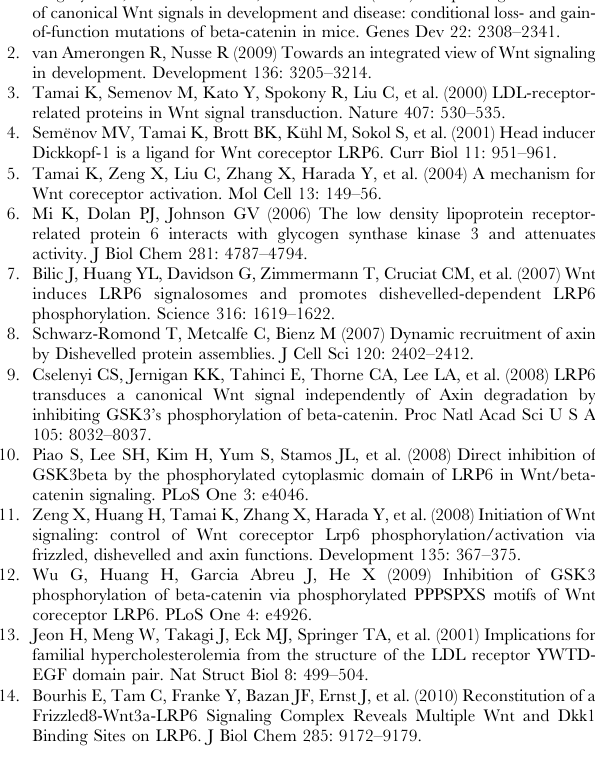
Figure S4 Apomab antibody crosslinking induces apoptosis in HT-1080 cells. We utilized the crosslinking-dependent proapop- tosis activity of Apomab antibody to optimize experimental conditions for crosslinking receptors on HT-1080 cells by either the whole IgG or F(ab 9 )2 fragment of anti-human-Fc antibodies (NA indicates no crosslinking antibody added). Results are shown for 1 m g/ml of all antibodies. Cell viability was monitored after